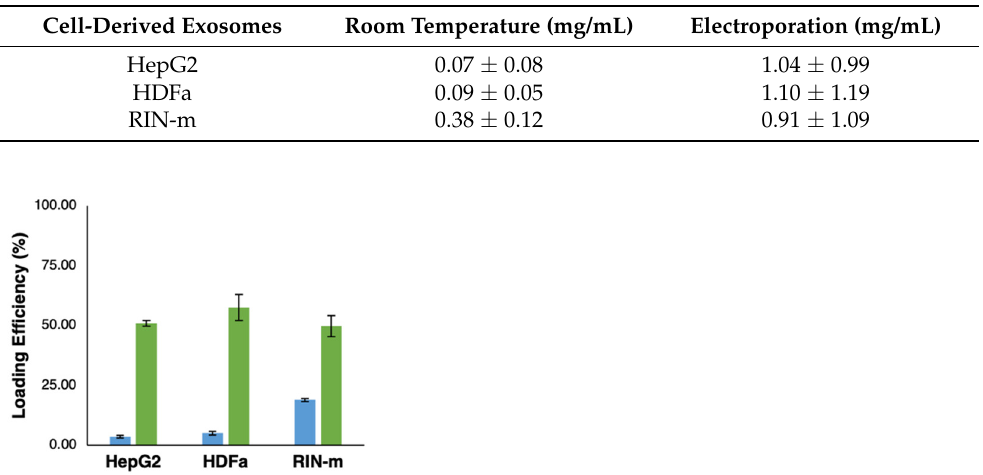
Table 1. FITC–insulin concentration in loaded HepG2-, HDFa- and RIN-m- derived exosomes in the room temperature (RT) and electroporation at 200 V and 50 µ F treatments. After both loading procedures, the samples were incubated at 37 ◦ C for 1 h to allow membrane regeneration before analysis.